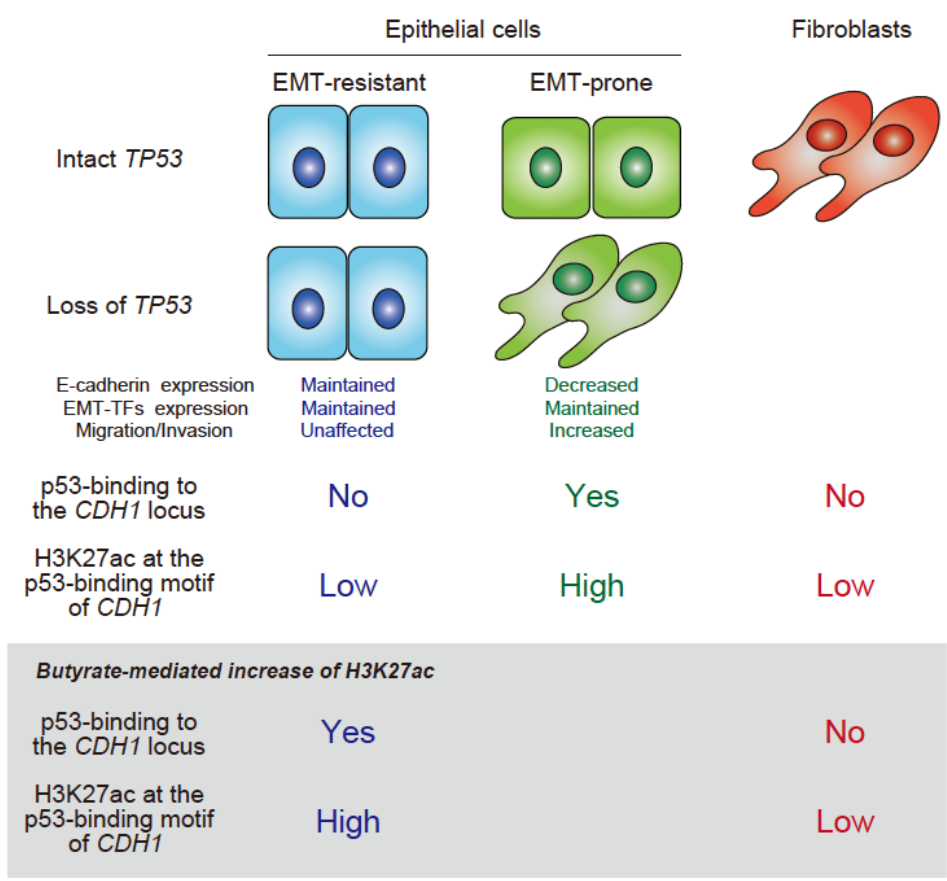
Figure 1. Illustration of the two novel modes of epithelial integrity, which do or do not involve the binding of p53 to the CDH1 locus. It is important to note that EMT can be induced even in some EMT-resistant cells, such as MCF7 cells in an inflammatory milieu [52].